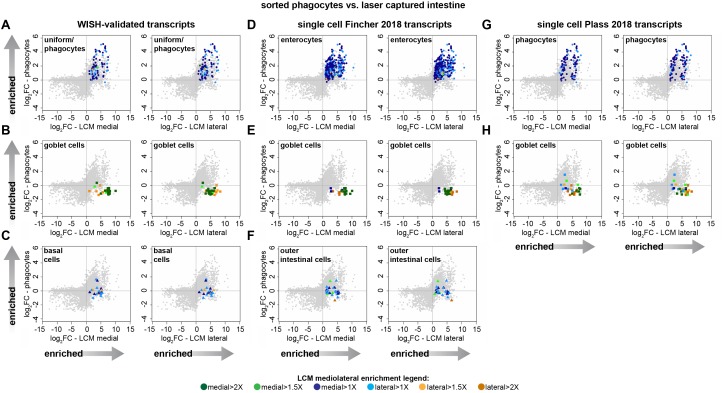
Validation of cell-type specific mRNA expression by WISH and correlation with single-cell analysis.(A–C) Transcripts with WISH patterns indicating enrichment in phagocytes (A), goblet-like cells (B), or basal cells (C), mapped onto plots of phagocyte (y-axis) vs. LCM medial/lateral (x-axis) fold-change expression (log2FC). (D–F) Transcripts found to be highly enriched in phagocytes (‘enterocytes’) (D), goblet cells (E), or basal cells (‘outer intestinal cells’) in Fincher et al. (2018), mapped onto phagocyte vs. LCM intestine expression plots. (G–H) Transcripts found to be highly enriched in phagocytes (G) or goblet cells (H) in Plass et al. (2018), mapped onto phagocyte vs. LCM intestine expression plots (basal cells were not described). Detailed numerical data are available in Supplementary file 1 and Figure 2—source data 1.